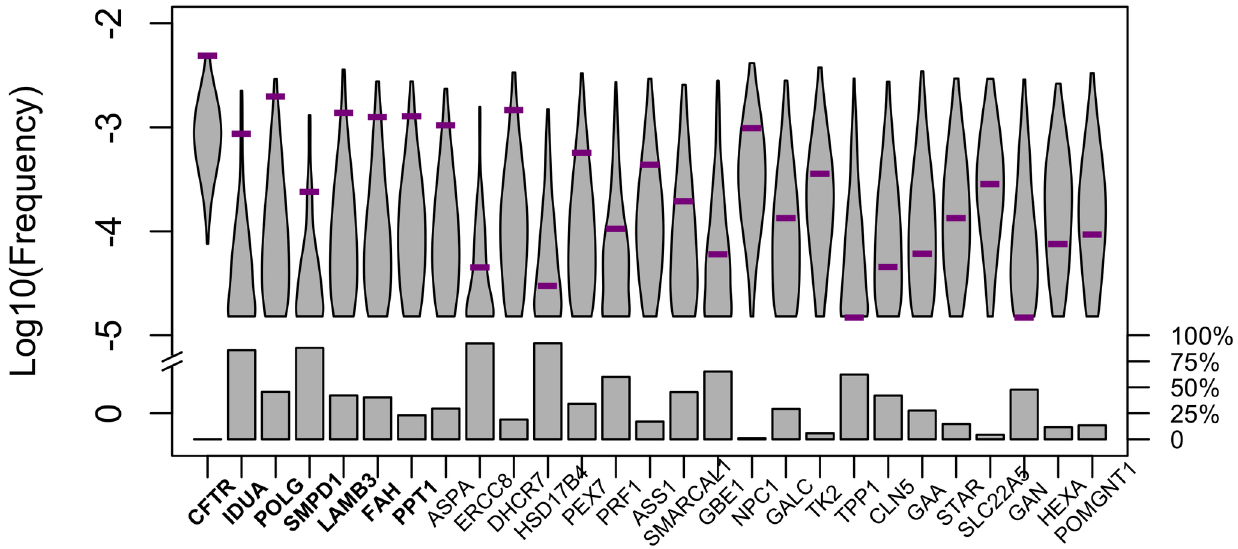
Fig 3. Sample allele frequencies at the gene level. The expectation(grey) is based on 1000simulations, assumingno fitness decreasein heterozygotes, but allowingfor compoundheterozygosity (see Methods for details). The sum of allelefrequencies of known recessivelethal diseasemutations in each gene(purple bars) was obtained from ExAC considering33,370Europeanindividuals.Genes are orderedaccording to the two-tailedp-value (S4 Table; see Methods). Genes are boldedwhen they differ significantly from expectation(at the 5% level). Violin plots show the distributionof the log 10 combinedallelefrequency of all segregatingallelesobtainedfrom simulations and boxes represent the fraction of simulations in which no deleteriousallelewas observedin the simulatedsample at present time.